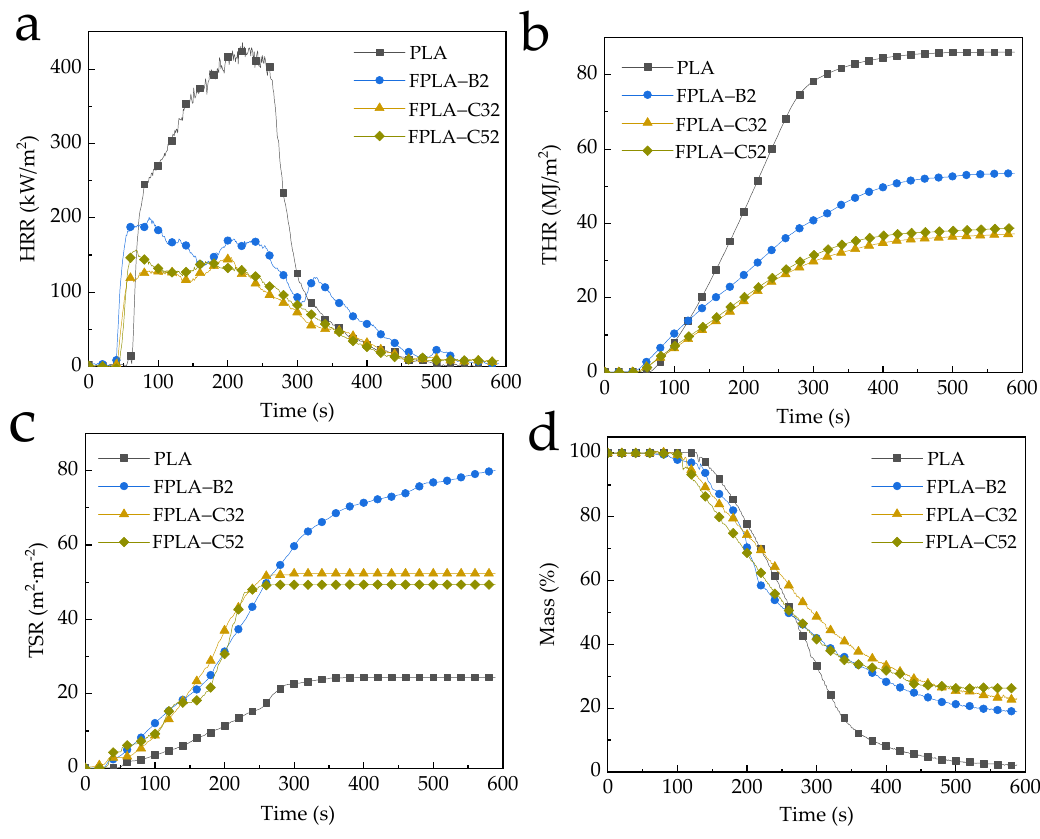
Figure 12. Typical CONE test results of PLA and FPLA composites: ( a ) HRR, ( b ) THR, ( c ) TSR, and ( d ) mass. HRR curves of selected samples are shown in Figure 12a, which a main factor